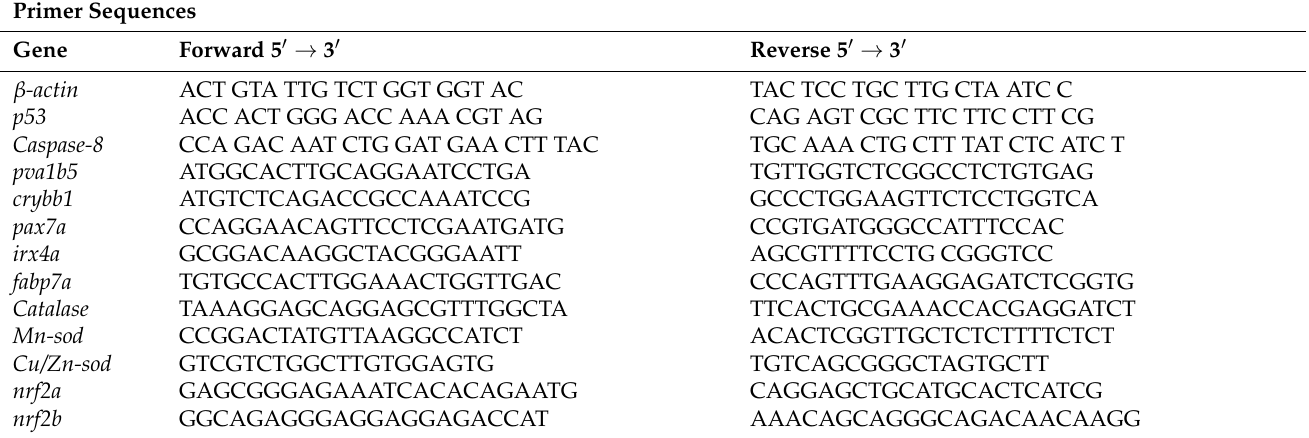
Table 2. Primer sequences used for real-time quantitative